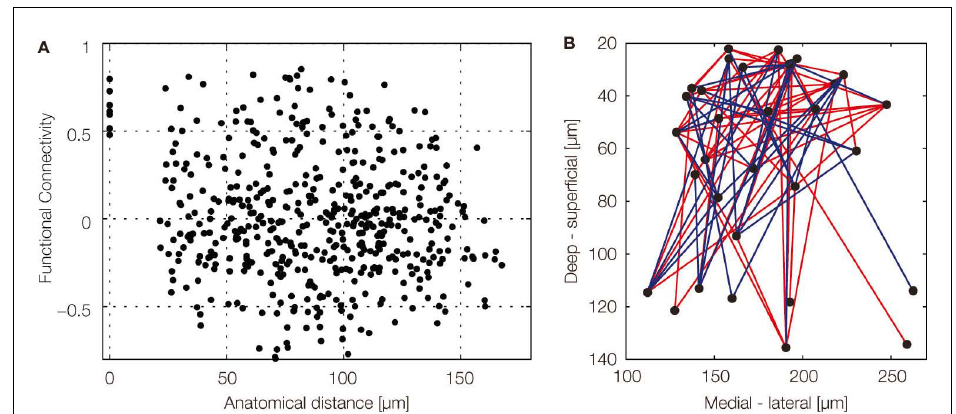
Figure 3 | Spatio-temporal organization of the glomerular network. (A) Functional connectivity as a function of anatomical distance of glomeruli innervated by a pair of projection neurons (PNs). We used Pearson correlation coeffi cients ( r ) of the responses of pairs of PNs to quantify functional connectivity. Firing rates from stimulus onset to 1 s after stimulus onset (20 time bins) were used. Pairs of PNs innervating different glomeruli show uncorrelated activity ( r = − 0.0556, n = 496). (B) A graph of functional connectivity mapped onto x – z plane of the antennal lobe. Each node represents a glomerulus. Only strong connectivity is shown, blue and red lines represent positive ( > 0.5) and negative (less than − 0.5) correlations, respectively. There are many functional connections among glomeruli in the superfi cial part of the antennal lobe. Although sampling was somewhat sparse, there is a tendency that strong functional connections are rare among deep glomeruli in response to the tested set of plant